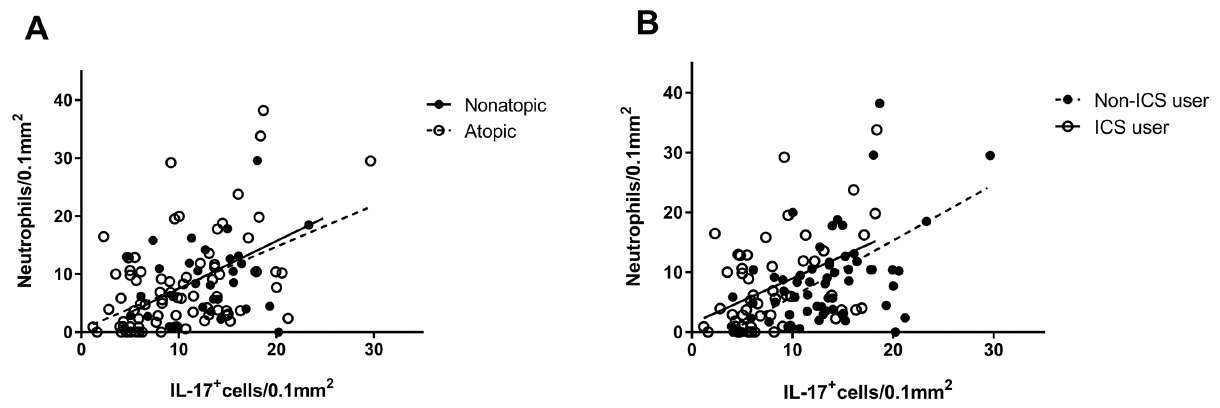
Fig 3. Positive correlation between the number of IL-17 + cells and neutrophils in the submucosa of bronchial biopsies from atopic (r s = 0.44; p < 0.001) and nonatopic (r s = 0.45, p = 0.009) asthmatics (A), or from asthmatics who are inhaled corticosteroid (ICS) (r s = 0.35; p = 0.01) and non-ICS (r s = 0.48; p < 0.0001) users